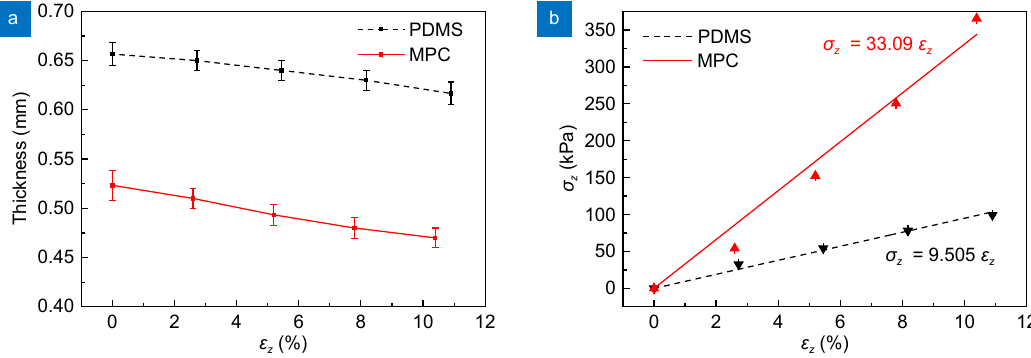
Fig. 2 | Mechanical properties of materials. ( a ) Lateral contraction of MPC and PDMS, ( b ) σ z - ε z curves of MPC and